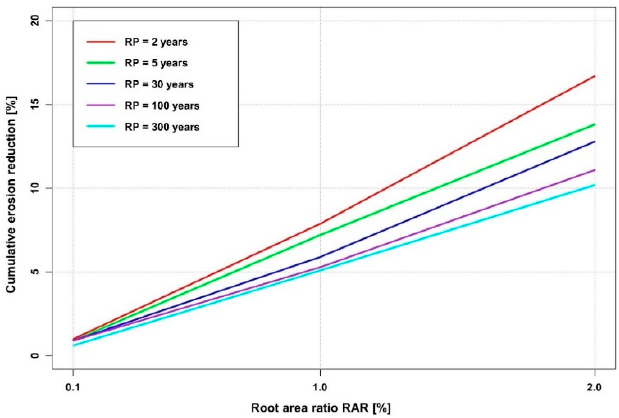
Figure 5. Cumulative erosion reduction (%) due to the mechanical effects of roots for return periods (RP) of 2, 5, 30, 100 and 300 years with RAR of 0.1%, 1% and 2% for the Thur River catchment.